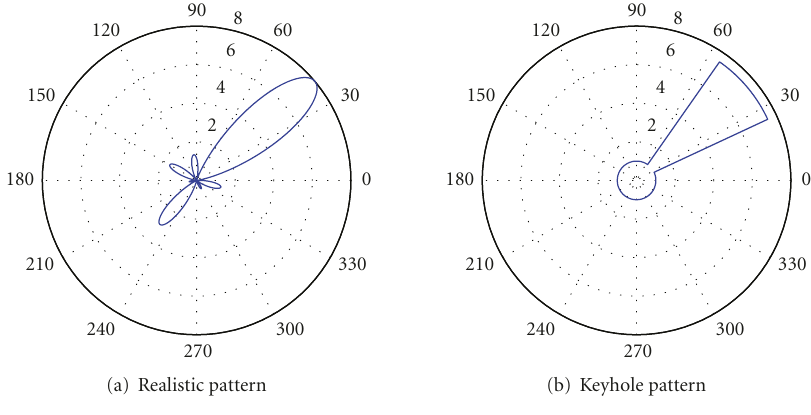
Figure 1: Antenna